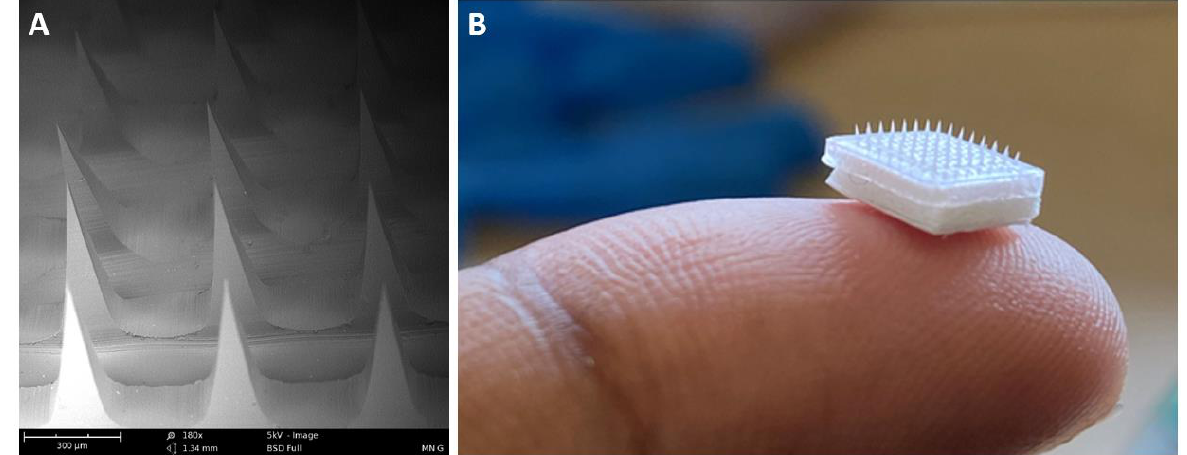
Figure 8. Characterization of MN . Scanning electron microscope and Digital images of microneedle arrays. Scanning electron microscope image of MN patch at a magnification of 180× ( A ). Digital image of MN depicting its size when placed on a fingertip ( B ).